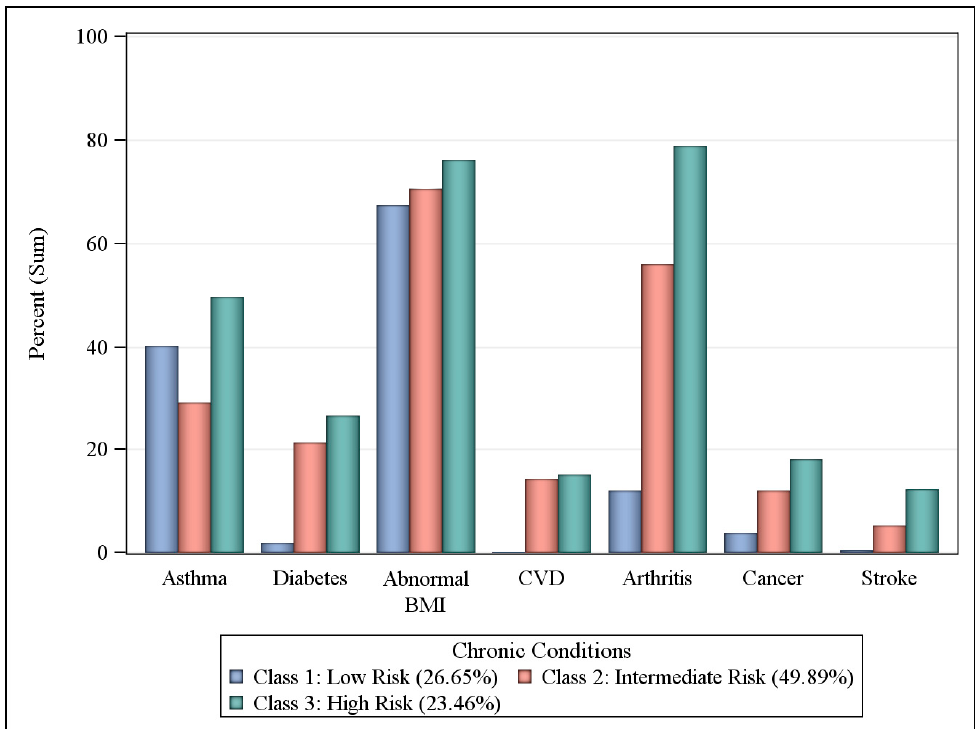
Figure 2. Probabilities of comorbid health condition by latent class, workers with COPD in KY, TN, NC, and WV BRFSS respondents, 2016 and 2017. Comorbid health conditions defined as having ever been told by a health professional that they had the condition of asthma, diabetes, cancer, CVD, arthritis, or stroke. Abnormal BMI defined as height and weight estimates that placed respondent as ‘underweight’, ‘overweight’, or ‘obese’. ‘underweight’, ‘overweight’, or